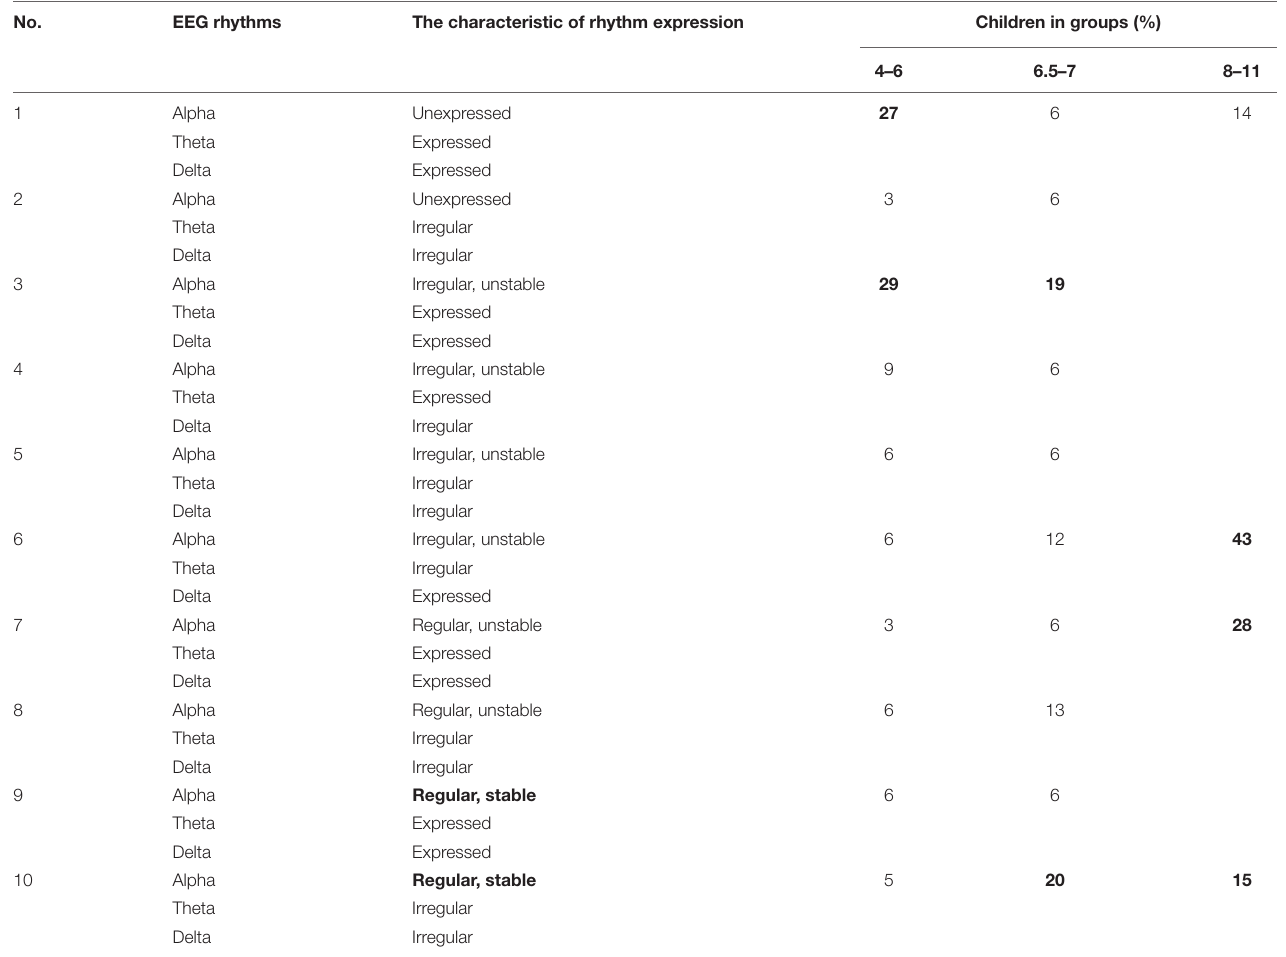
Bold emphasis refers to significant variances in alpha, theta, and delta rhythm expressions in children’s age group.